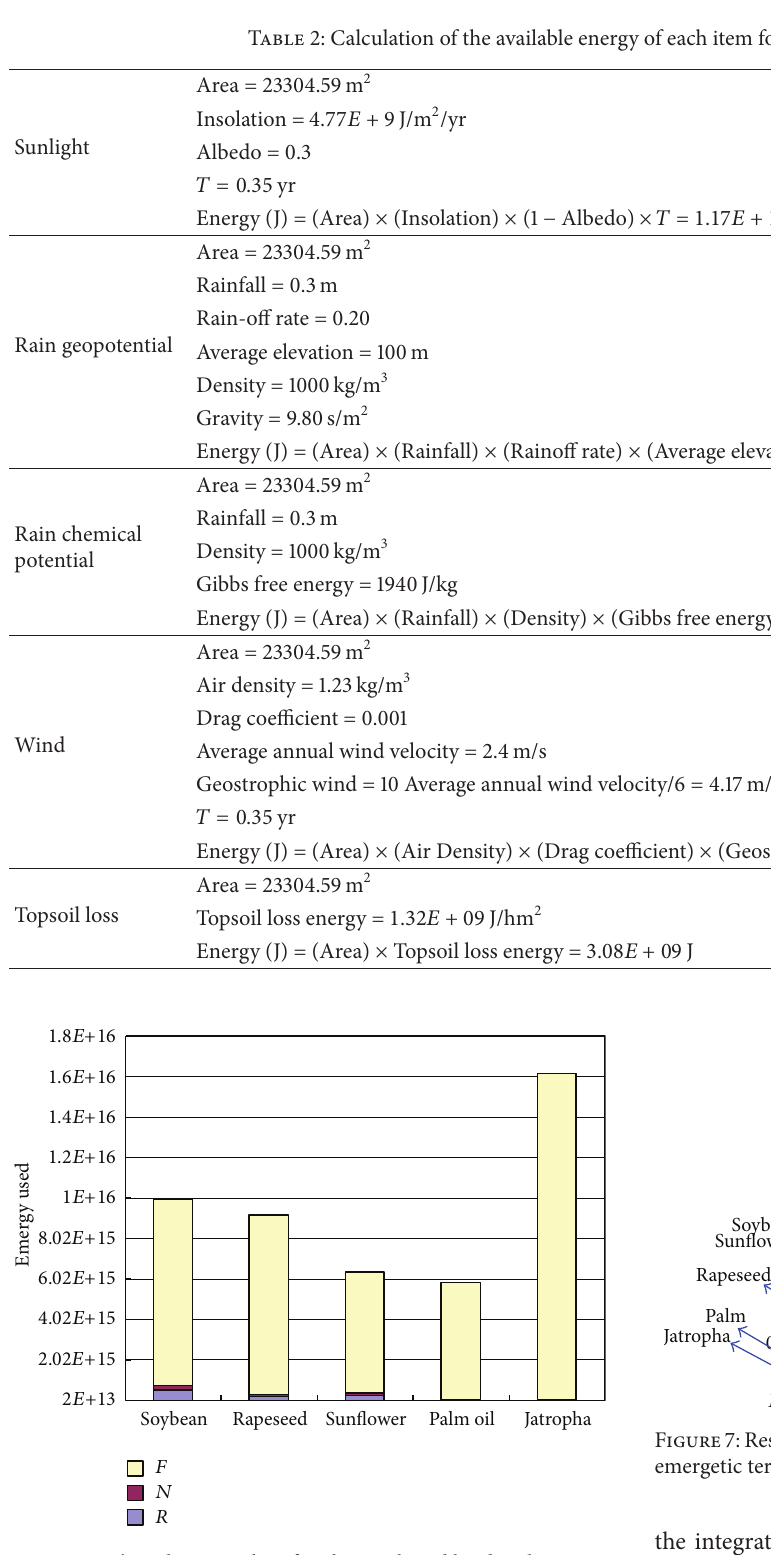
Figure 6: The solar emjoules of each crop-based biodiesel system.